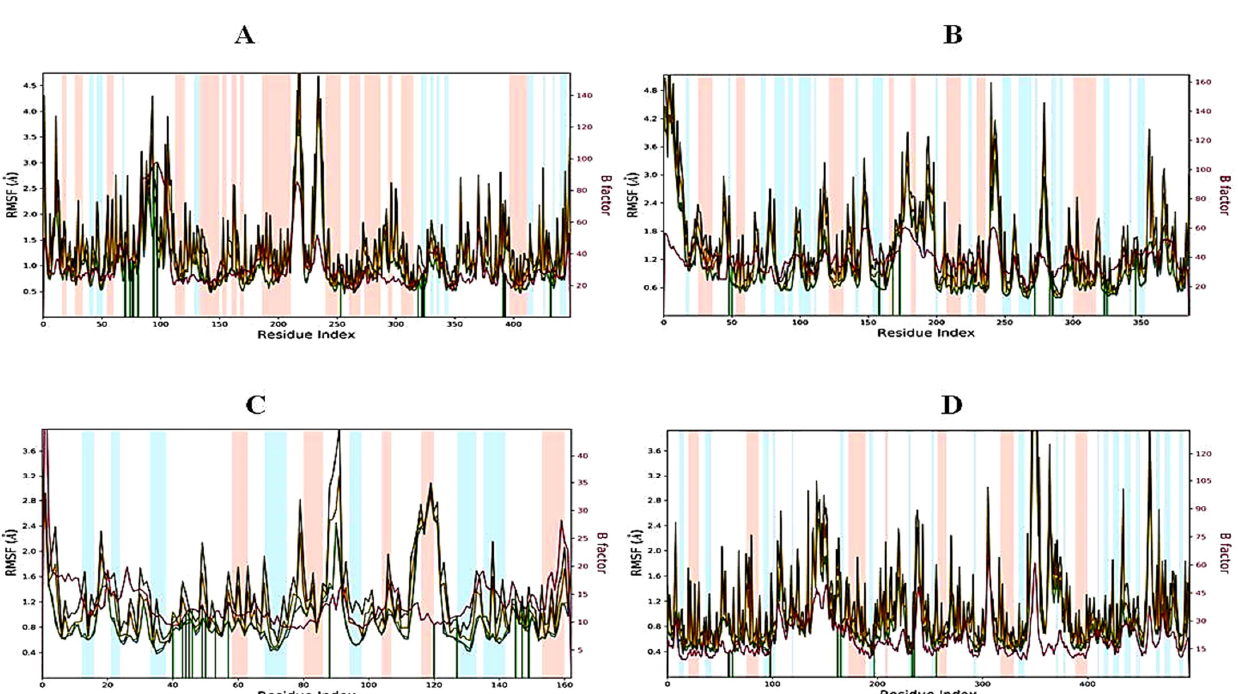
Figure 5 . RMSF graph of 3,7-cyclodecadien-1-one of CLO with target proteins for 100 ns: ( A ) 3,7-cyclodecadien-1-one in complex with 1EA1, ( B ) 3,7-cyclodecadien-1-one in complex with 1IYL, ( C ) 3,7-cyclodecadien-1-one in complex with 1HD2, ( D ) 3,7-cyclodecadien-1-one in complex with 1HNY protein. Color legends: C α (blue color), side chains (green color), heavy atoms (yellow color), ligand with protein (dark pink color), ligand with ligand (pink color).